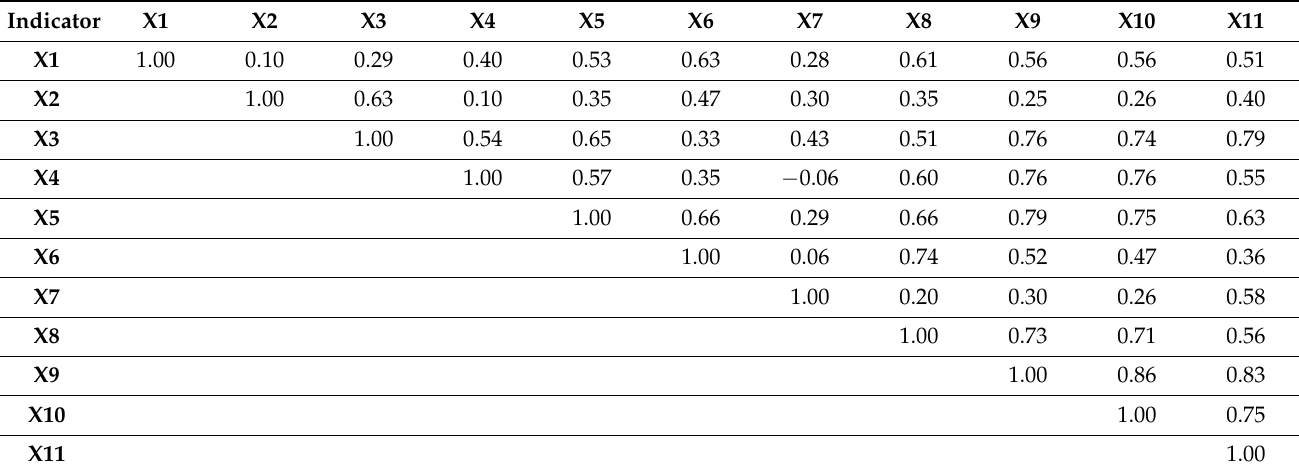
Table 4. Correlation matrix (for significance level p < 0.005).